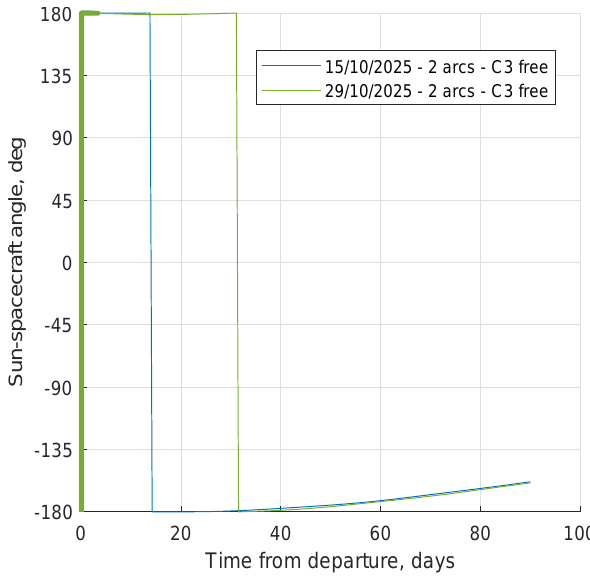
Figure 4. Time evolution of Sun–spacecraft relative angle for two SEL2 case